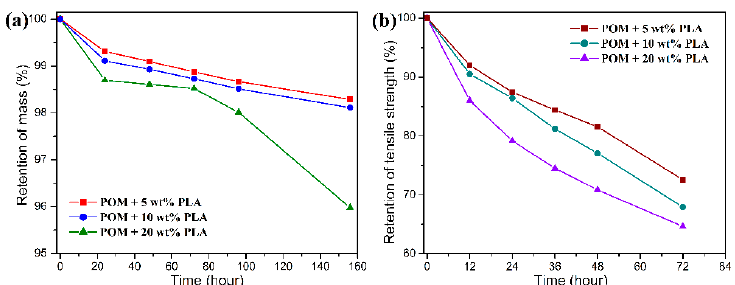
Figure 12. ( a ) Mass, and ( b ) tensile strength retention as a function of degradation time for POM/PLLA bicomponent fibers in an acid medium.